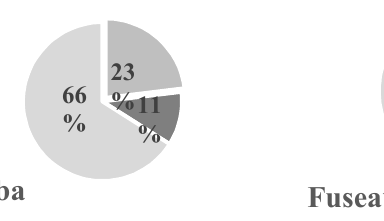
Figure 2. Distribution of saturated fatty acids (SFA), monounsaturated fatty acids (MUFA), and polyunsaturated fatty acids (PUFA) in Jerusalem artichoke leaf protein concentrate (JAPC) extracted from the green biomass of three clones (Alba, Fuseau, and Kalevala).